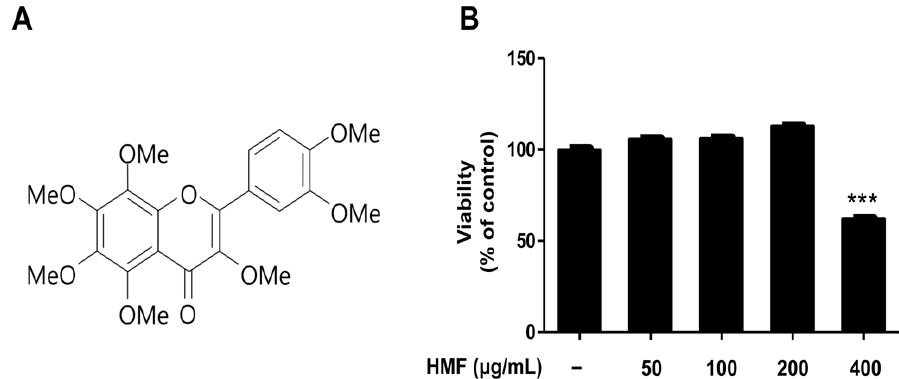
Figure 1. Chemical structure and cytotoxicity of 3,5,6,7,8,3 ′ ,4 ′ -heptamethoxyflavone (HMF) isolated from C . unshiu peel. ( A ) Chemical structure and ( B ) cytotoxic effects of HMF on human dermal fibroblast neonatal (HDFn) cells. HDFn cells were treated with HMF (50, 100, 200, and 400 μ g/mL) for 24 h. Values are means ± standard deviation (SD) of three independent experiments and relative to percentages of control cells. Statistical significance of differences was evaluated using one-way analysis of variance (ANOVA) followed by Tukey’s test. *** p < 0.001 versus HDFn cells without HMF